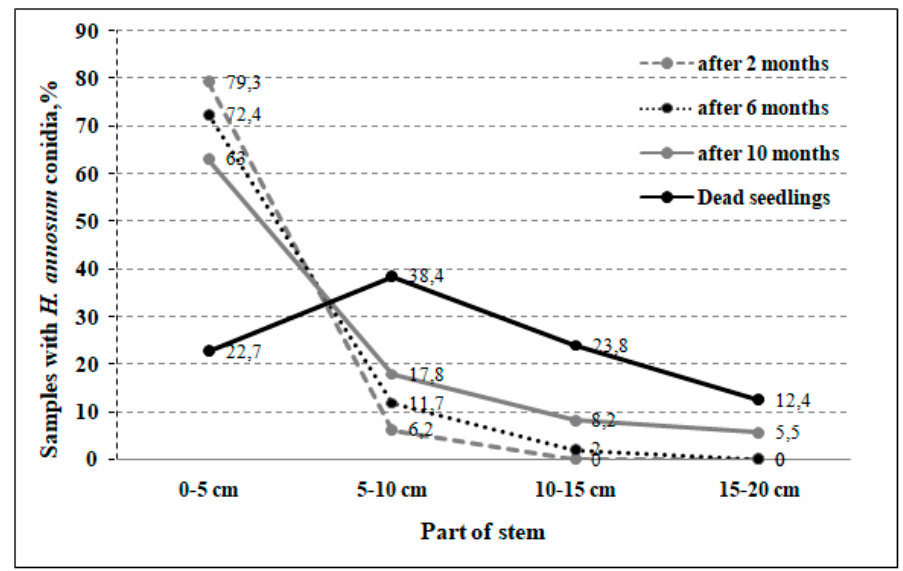
Figure 2. H. annosum incidence rate and growth in seedlings stem wood two, six, and ten months after inoculation the points represent four strains averages in 12 Scots pine half-sib families. Incidence rate and pathogen growth in dead seedlings presented as average from all dead seedlings 10 months after inoculation. Table 1. Pairwise comparison of H. annosum strains in between and with control (sample size n = 36). Pairs of treatments for comparison Wilcoxon Z DSCF value Pr > DSCF